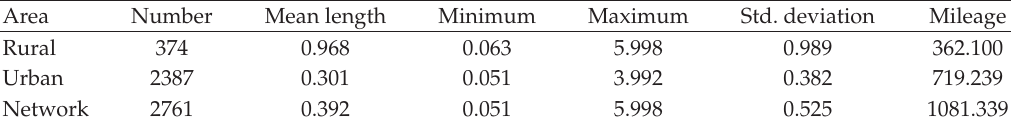
Table 2: Original statistics for the length and